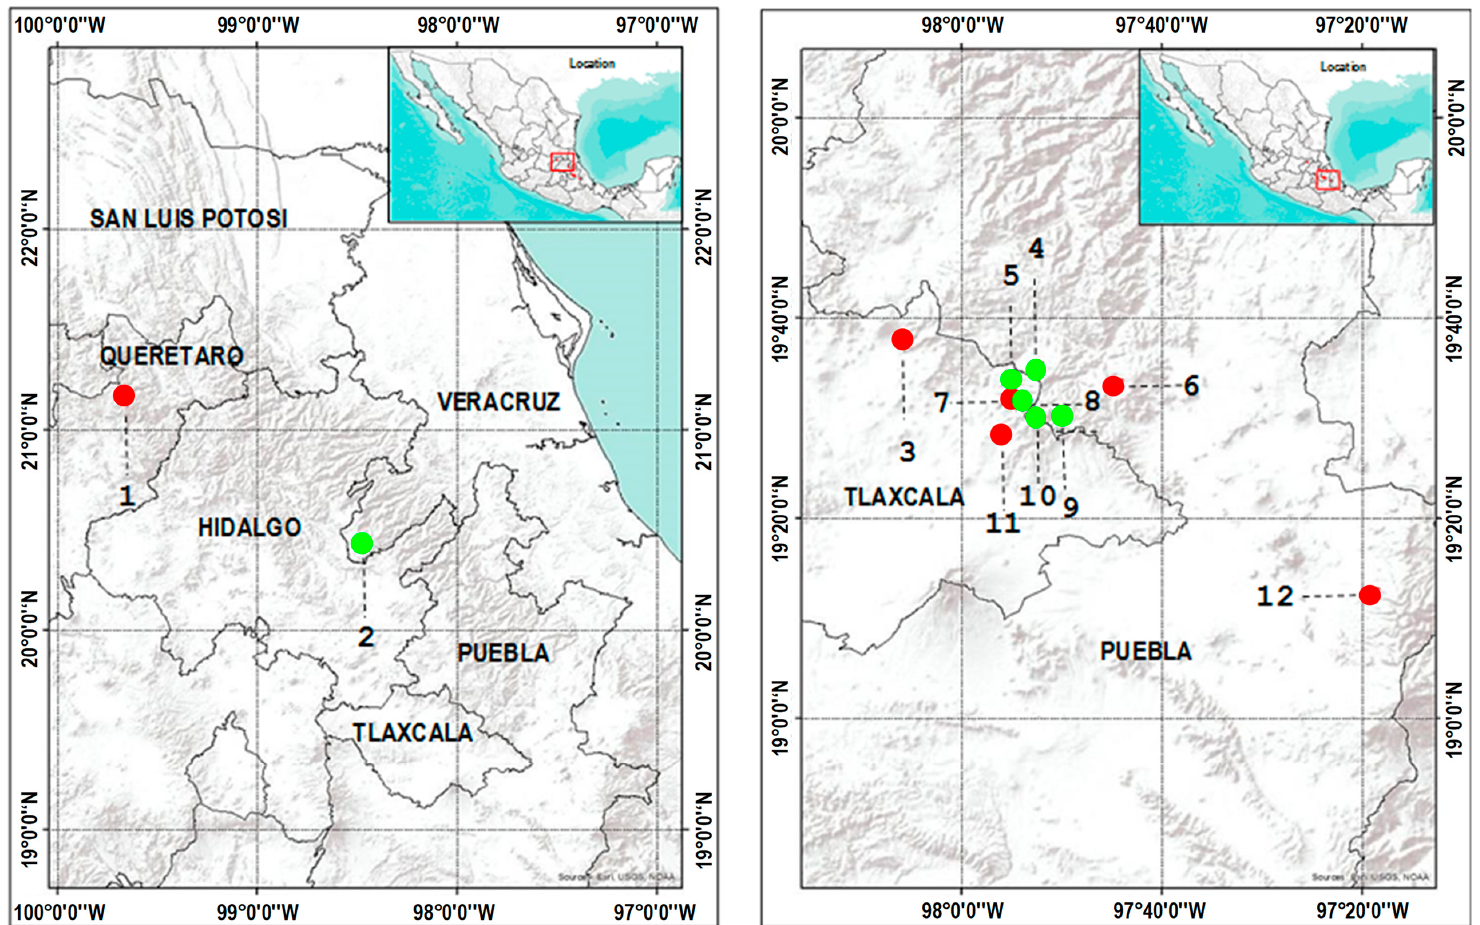
Figure 1. Geographic location of natural populations of Pseudotsuga menziesii (Mirb.) Franco, where plant material was collected. Left map represents the most northern surveyed populations in the states of Veracruz and Quer é taro. Right map shows populations located in the states of Tlaxcala and Puebla. Names of populations are as follows: ( 1 ) La Barranca, ( 2 ) Carbonero Jacales, ( 3 ) Tlaxco, ( 4 ) Cruz de Le ó n, ( 5 ) Emiliano Zapata, ( 6 ) Tlalmotolo, ( 7 ) La Rosa, ( 8 ) Villareal, ( 9 ) Cuatemoxla, ( 10 ) La Caldera, ( 11 ) Axopilco, ( 12 ) Apizaquito. The color of the dots indicates the genetic group assigned by the STRUCTURE